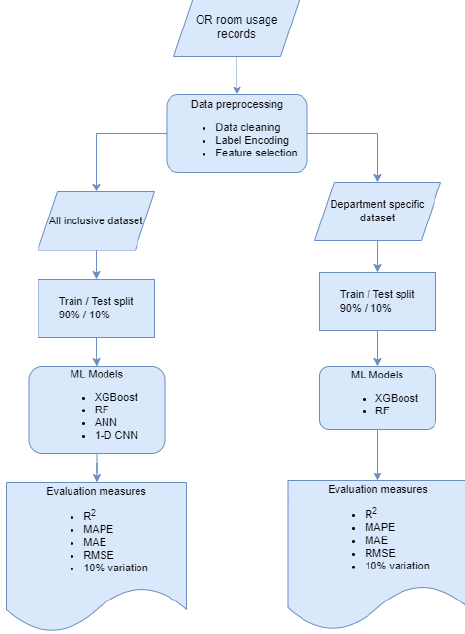
Figure 2. Process flowchart of data and